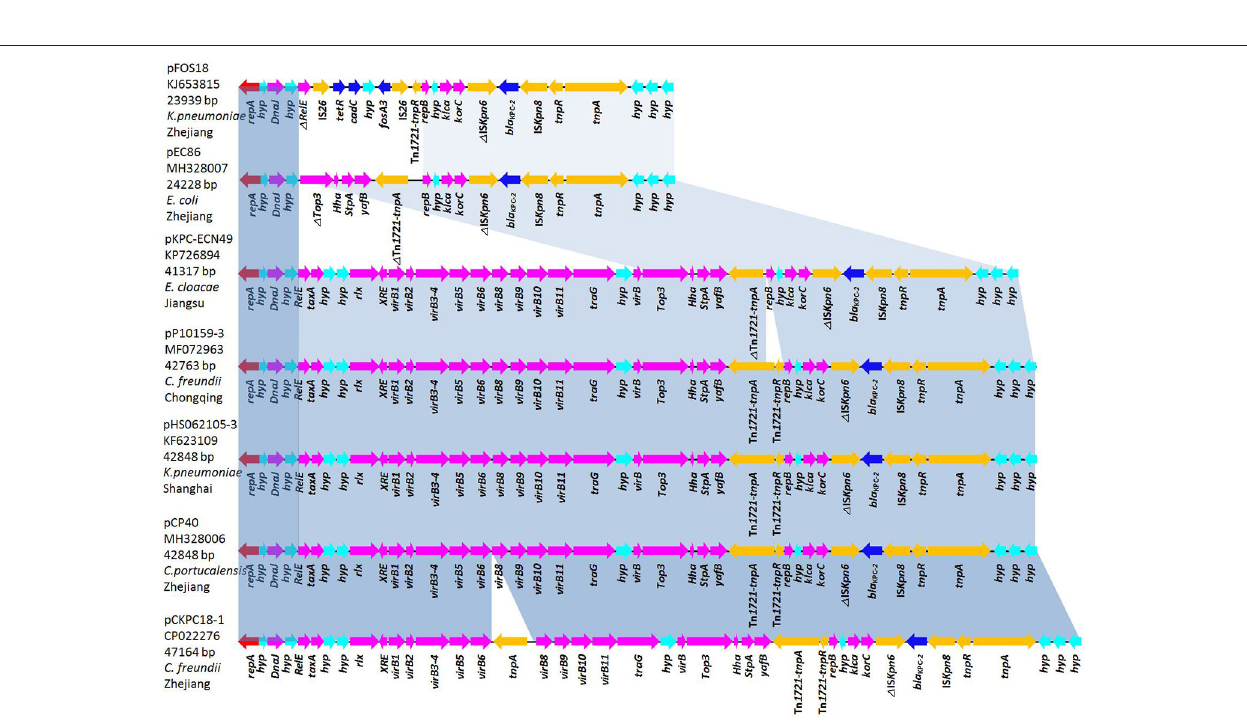
FIGURE 2 | Comparative analysis of the bla KPC -harboring untypeable plasmids pFOS18 (KJ653815), pEC86 (MH328007), pKPC-ECN49 (KP726894), pHS062105-3 (KF623109), pP10159-3 (MF072963), pCP40 (MH328006), and pCKPC18-1 (CP022276). Light-blue shading denotes shared regions of homology in each adjacent plasmid. Notably, the type IV secretory pathway (VirB1-10) present in pKPC-ECN49, pHS062105-3, pP10159-3, pCP40, and pCKPC18-1 is absent in pFOS18 and pEC86. Open reading frames (ORFs) are depicted by arrows and are colored based on predicted gene function. Resistance genes are indicated with deep-blue